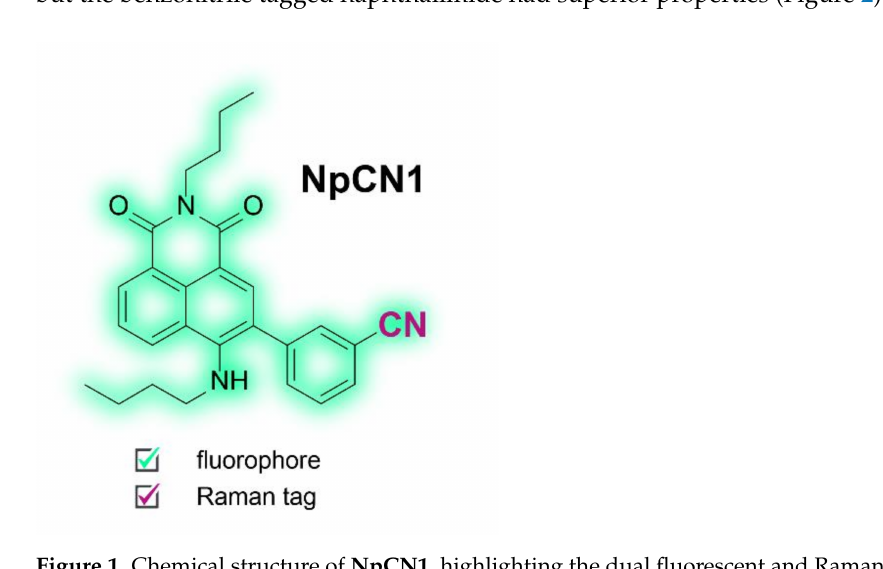
Figure 1. Chemical structure of NpCN1 , highlighting the dual fluorescent and Raman modalities. NpCN1 was synthesised in a three-step reaction (Scheme S1). First, the condensation of n -butylamine with 4-bromo-1,8-naphthalic anhydride gave 4-butylamino- N -butyl-1,8- naphthalimide [37]. The subsequent bromination of 1 afforded 3-bromo-4-butylamino- N - butyl-1,8-naphthalimide, which was subjected to a Suzuki cross-coupling reaction with 3- cyanophenylboronic acid to produce NpCN1 in good yields (for complete organic synthetic procedures, see